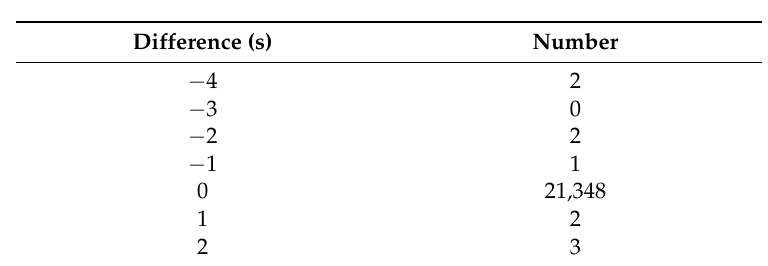
Table 5. The distribution of the differences between MRT estimates derived from IGS final and ultra-rapid ephemerides using ARTA. The ‘Difference’ in column one is MRT estimate derived from day of 2014 and